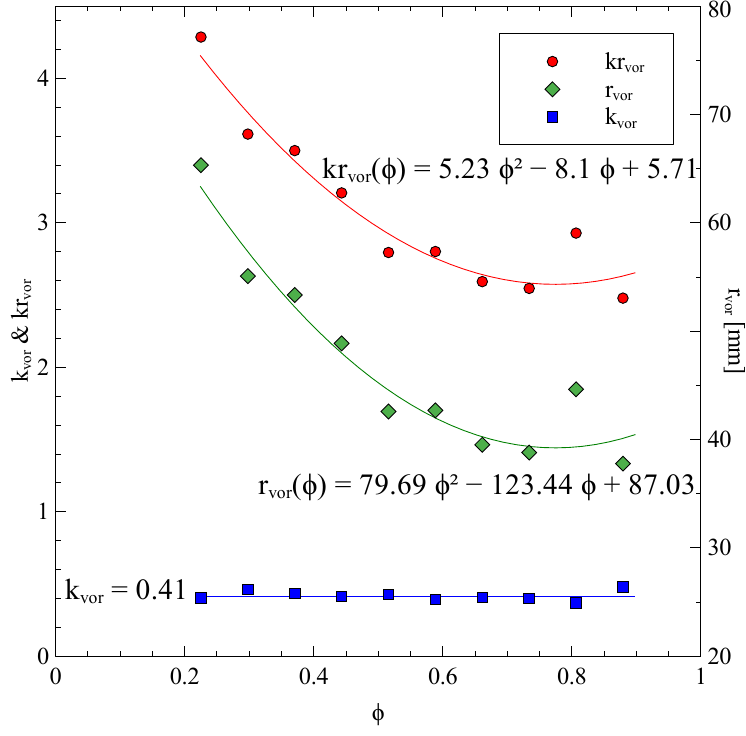
Figure 25. The measured vortex radii and the corresponding k vor .